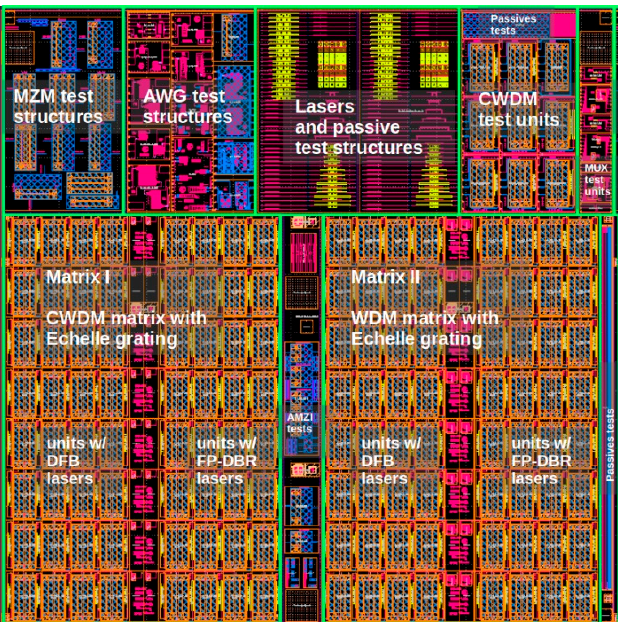
Figure 4. Mask layout of the reticle created in Nazca-Design, including two SiP matrix circuits for 4 wavelength CWDM and WDM, and test structures (top) of various components provided by the L3MATRIX designers. The fabrication was carried out at the AMS foundry; Detailed SEM images of the components are shown in Section 3.